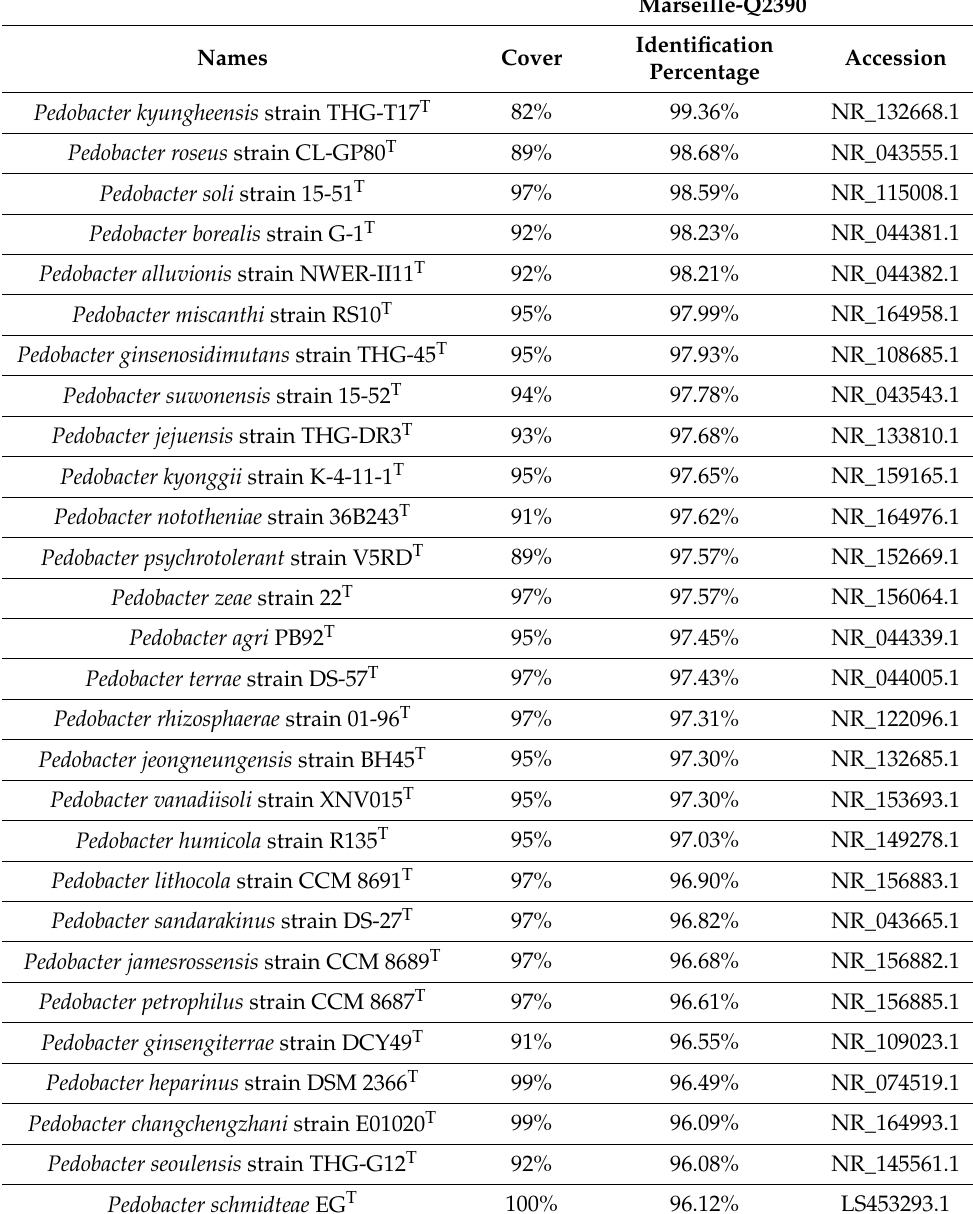
Table 1. Taxonomic assignment obtained by a BLASTn search of 16S rRNA genes of the strain